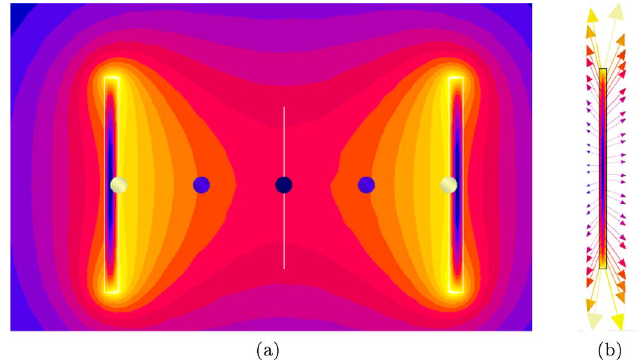
Figure 5. (a) Flux density and position of the 5 points where measurements are compared with the simulation and (b) Lorentz forces dF L distribution within the section A-A of the Coil55 (see Fig. 4).